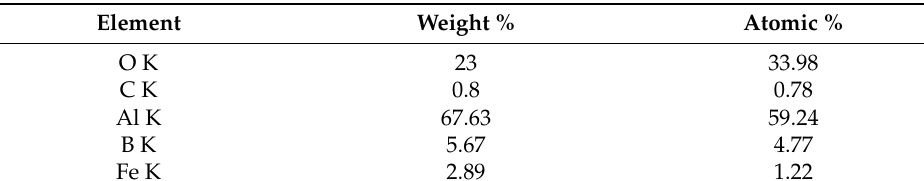
Figure 11. EDX analysis spectrum at point A in specimen welded at normal conditions. Table 8. EDX quantitative analysis data at point A in specimen welded at normal conditions.